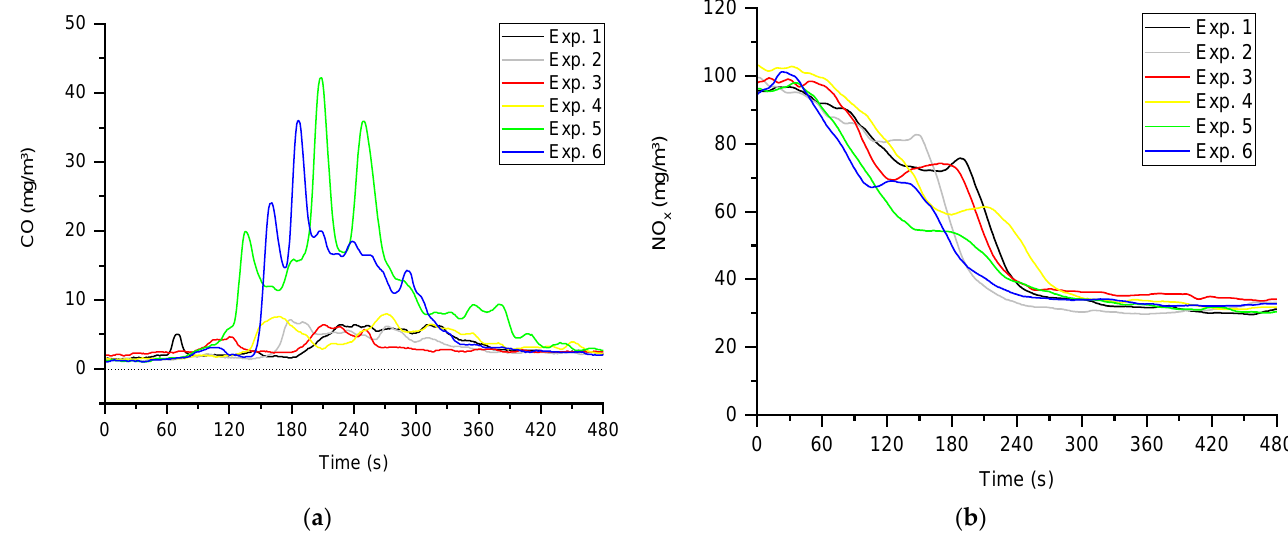
Figure 8. Gaseous emissions content in the flue gas for the transition phase; ( a ) CO and ( b ) NO x (time after the start of the phase) for standardized 13 vol. % O 2 content in dry flue gas (STP).